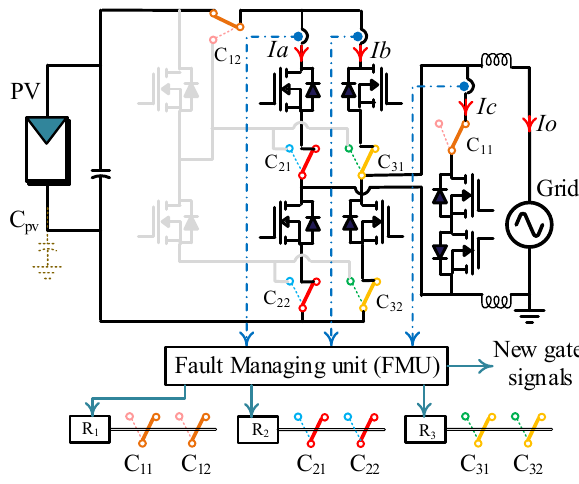
Figure 6. Fault managing unit of IFTPVI.